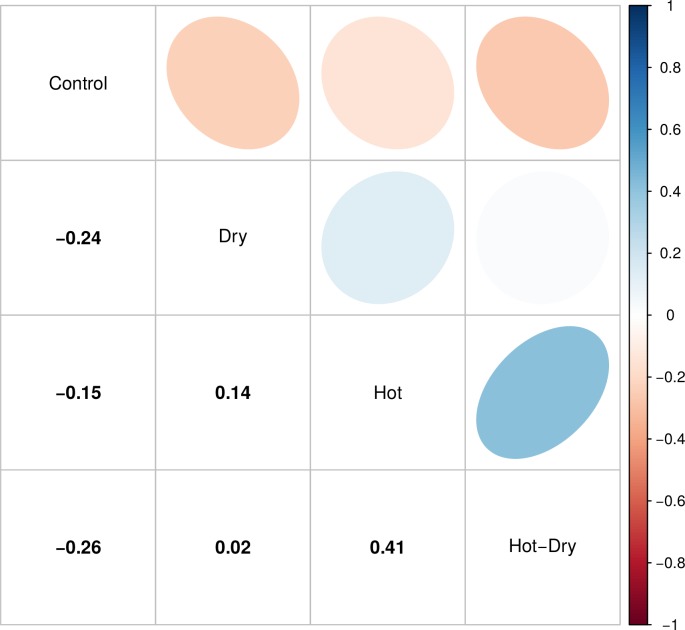
Pairwise correlations of selection intensities on single gene
expression levels in different conditions.Blue indicates a positive and red a negative correlation. Values are
given in the lower triangle. Confidence intervals for correlations:
Control-Dry: -0.25, -0.22; Control-Hot: -0.11, -0.08; Control–Hot-Dry:
-0.23, -0.20; Dry-Hot: 0.08, 0.11; Dry–Hot-Dry: 0.00, 0.03; Hot–Hot-Dry:
0.33, 0.36.